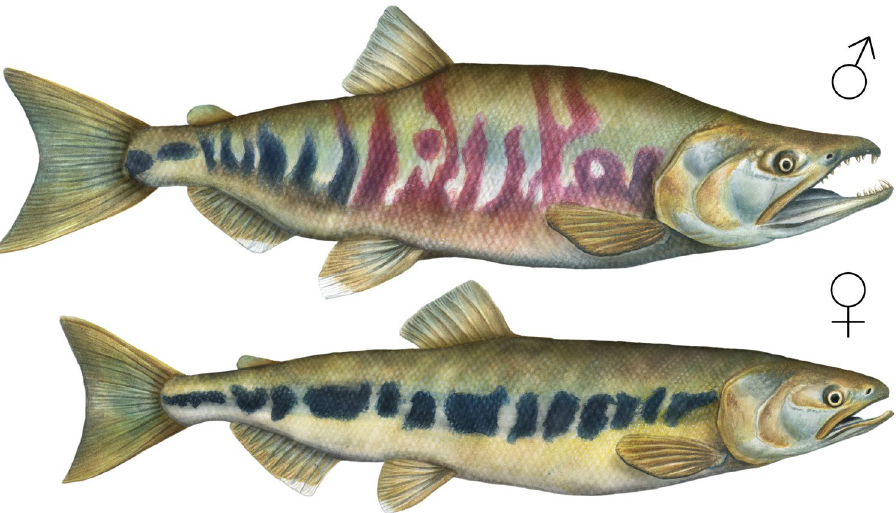
Figure 3. Spawning male (top) and female (bottom) chum salmon (original artwork by Dorian Noël